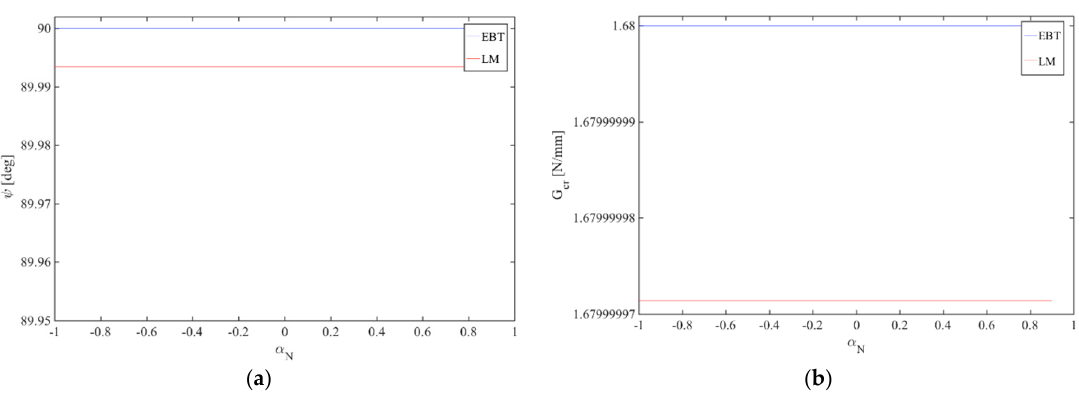
ψ G . ; ( b ) Critical energy cr